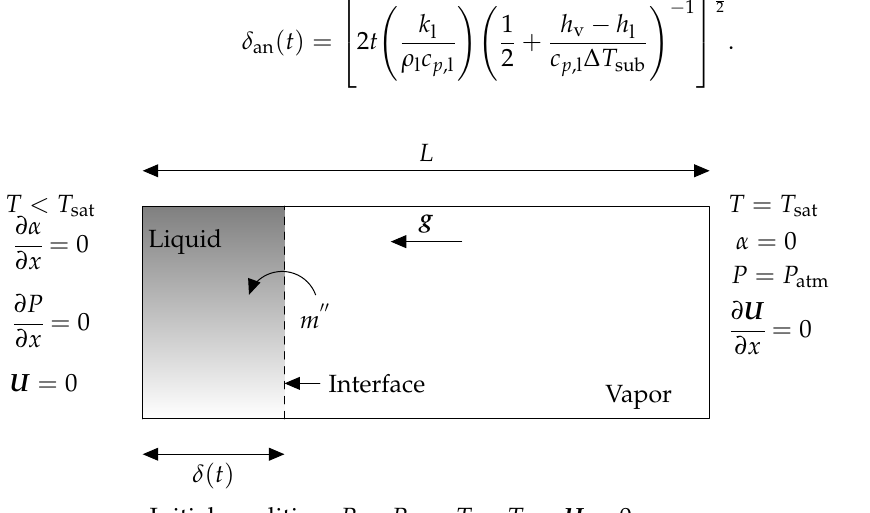
Figure 5. The graphic depicts the 1D condensation by heat conduction problem (also known as the Horizontal film condensation problem) and the accompanying boundary conditions. Gray signifies liquid, whereas white suggests a vapor-filled region of geometry. Both vapor and base liquid are at their saturation temperature. The phase transition takes place at the gas–liquid interface, as shown by the dashed line. Phase change occurs when the wall in contact with the nanofluid cools below superheat. As a consequence of the condensation phase change explained above, the interface, which also acts as a measure for the thickness of the condensed water layer, is moving to the